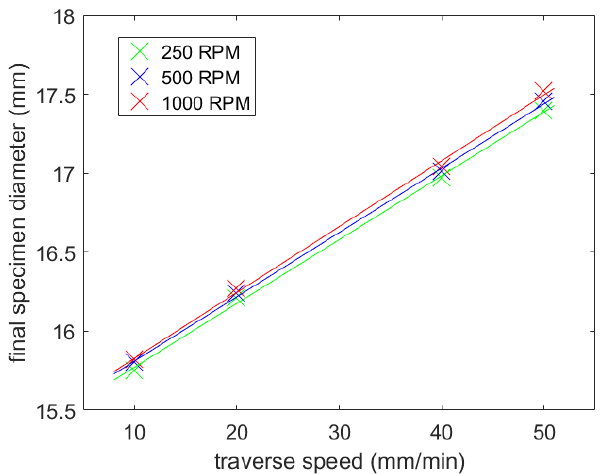
Figure 7. Influence of the traverse speed and the rotational speed on the final diameter (square rod).